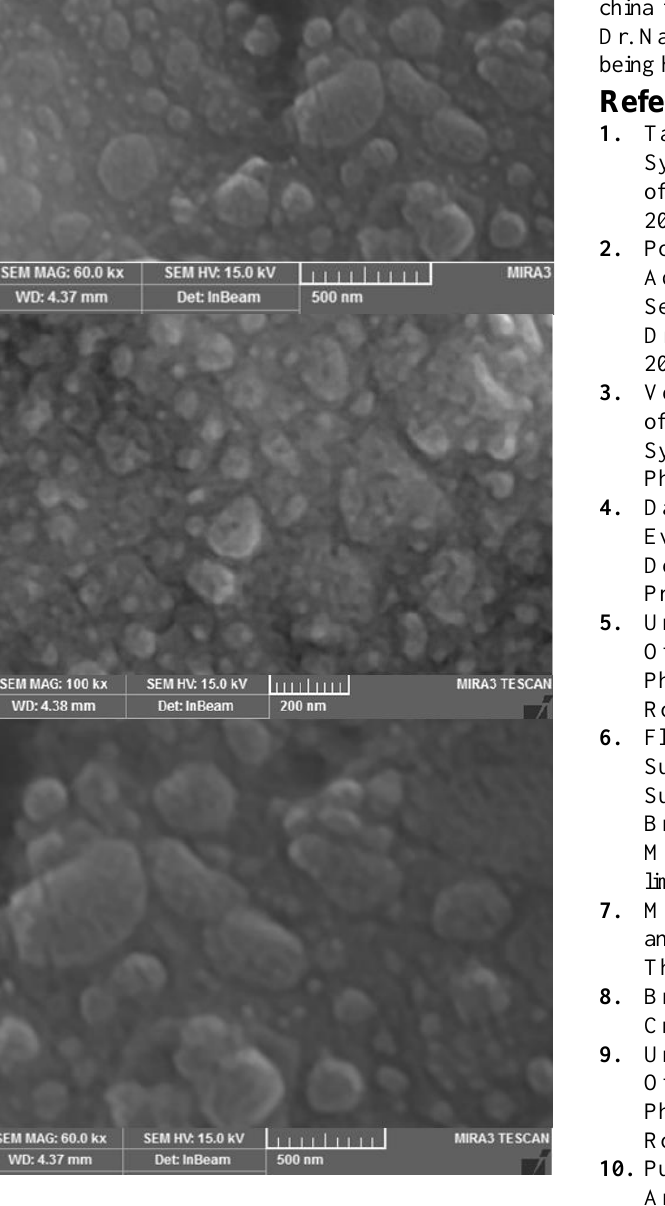
Figure 5. FESEM image of PIR selected SNEDDS formula